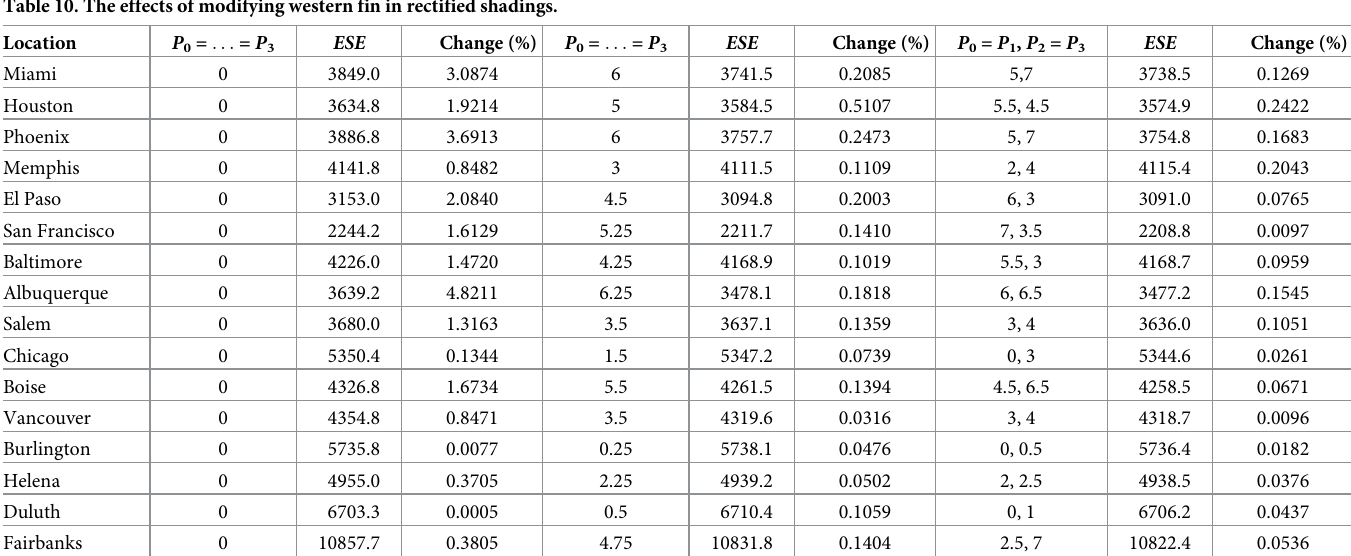
Table 10. The effects of modifying western fin in rectified